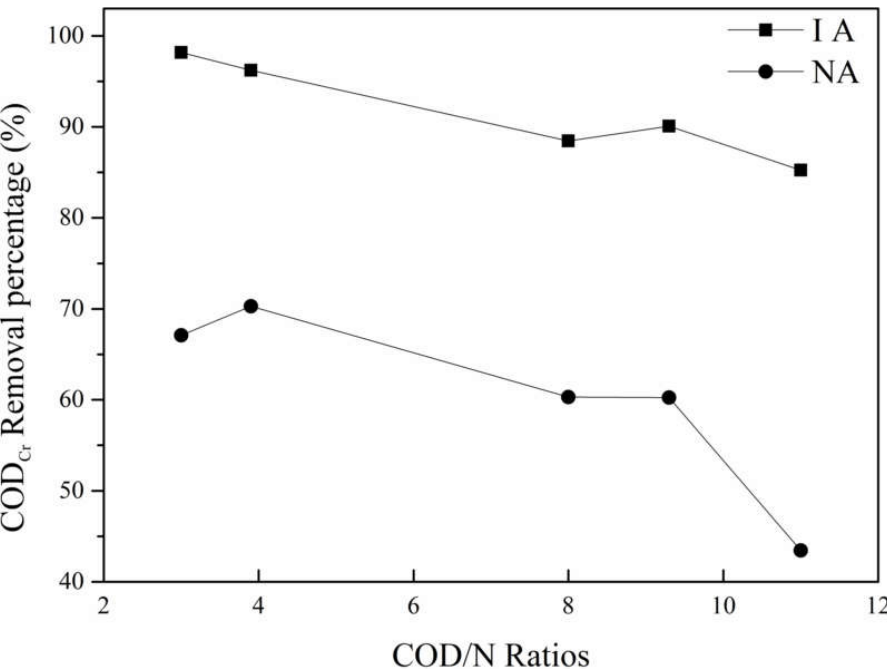
Figure 5. The removal efficiency of COD Cr in HSSF-CWs with IA and NA under different COD/N ratios. (IA: Intermittent aeration; NA: Non-aeration).